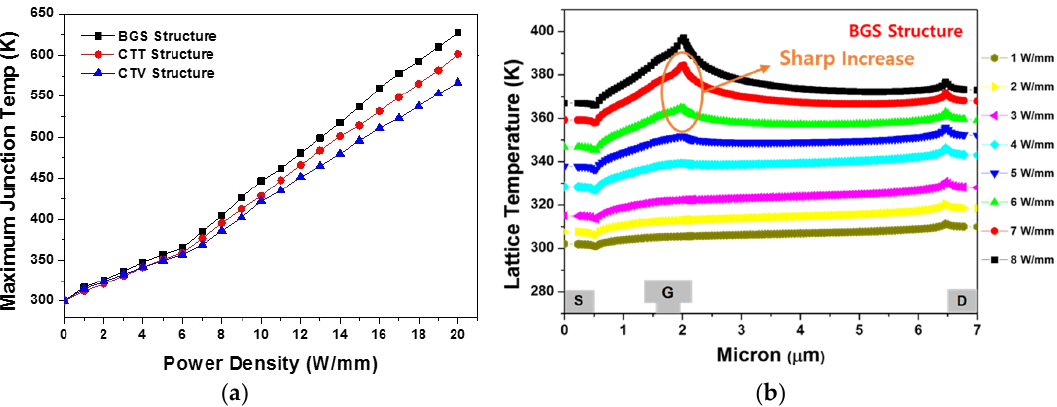
Figure 10. Steady-state thermal properties as a function of the drain power density: ( a ) maximum junction temperature for the BGS, CTT, and CTV structures and ( b ) lattice temperature of the BGS structure inside the 2-DEG channel.